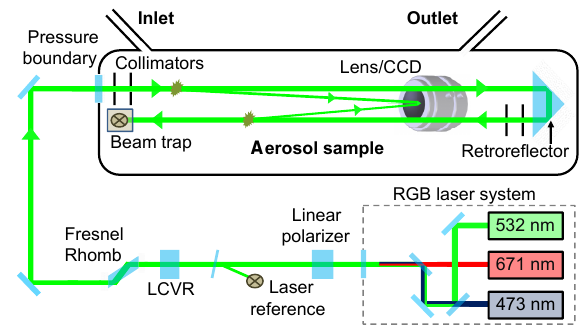
Figure 1. The PI-Neph instrument concept. Figure adapted from Dolgos and Martins